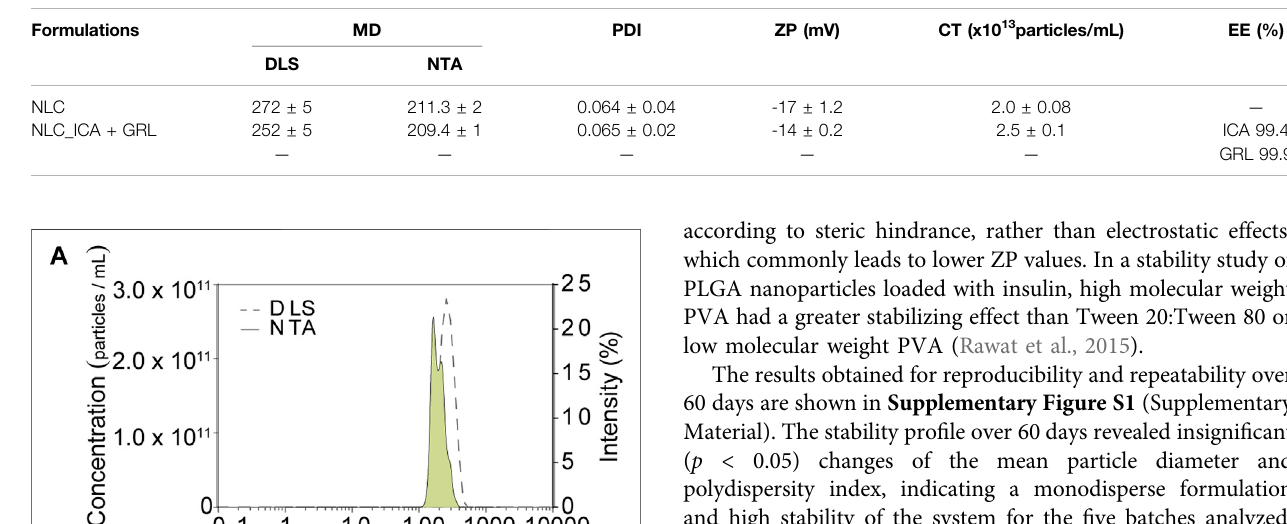
TABLE 1 | Characterization of the NLCs without repellents and containing geraniol (GRL) and icaridin (ICA): Dynamic light scattering (DLS) analyses of mean diameter (MD) andpolydispersityindex(PDI);nanotrackinganalysis(NTA)ofmeandiameter(MD)andNLCsconcentration(CT);microelectrophoresisanalysisofzetapotential(ZP);and ultracentrifugation/HPLC analysis of encapsulation ef fi ciency (EE). The analyses were performed in triplicate (mean ± SD).